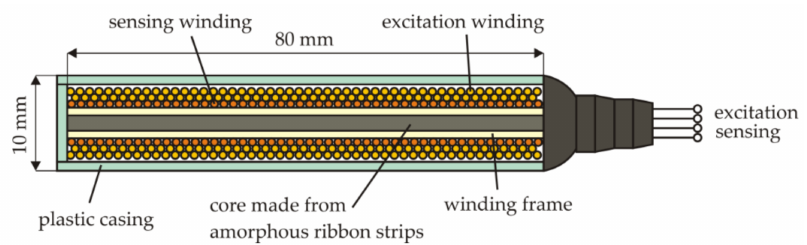
Figure 4. Standard VEMA sensor